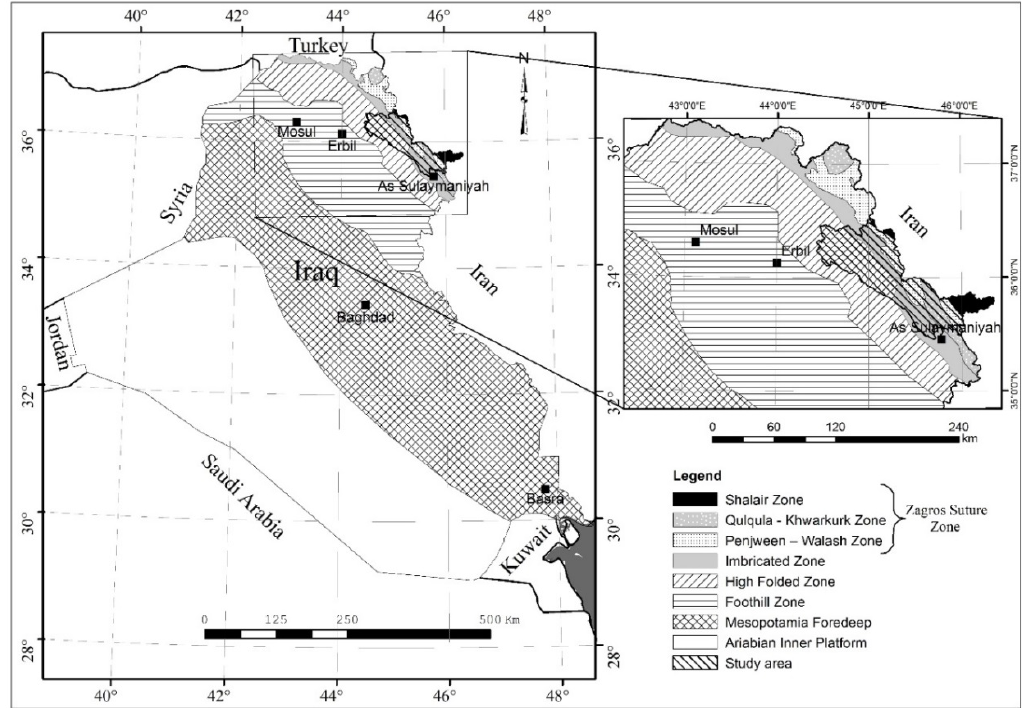
Figure 1. Location map of the study area in the High Folded Zone (HFZ), Imbricated Zone (IZ) and Zagros Suture Zone (ZSZ) (after